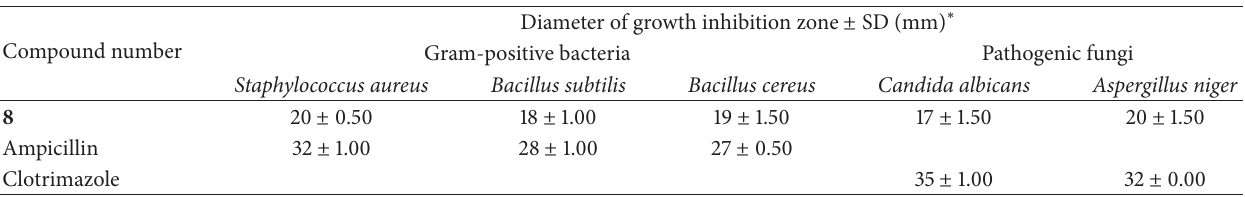
Table 4: Diameter of growth inhibition zone (mm) of the target compound 8 , ampicillin, and clotrimazole towards the test microorganisms.